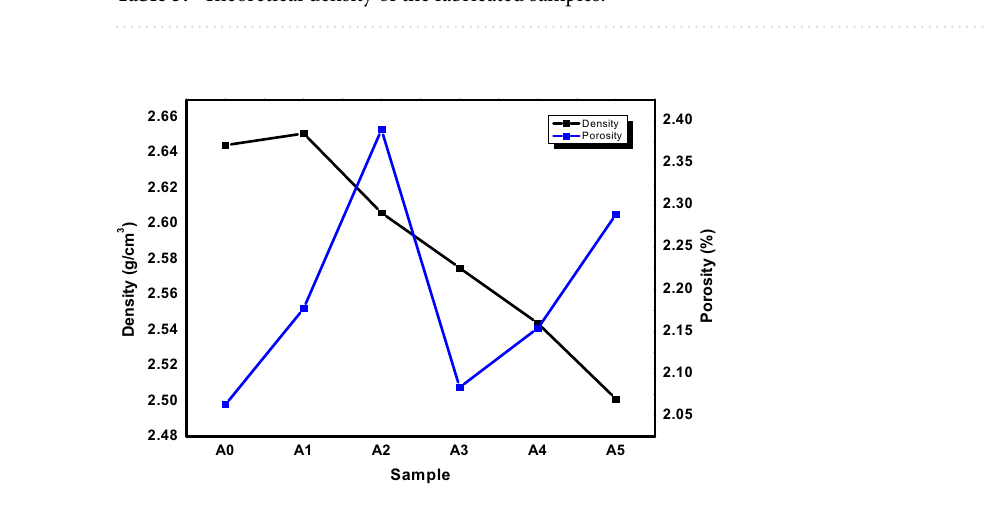
Figure 8. Density and porosity of the produced AMCs with PKSA